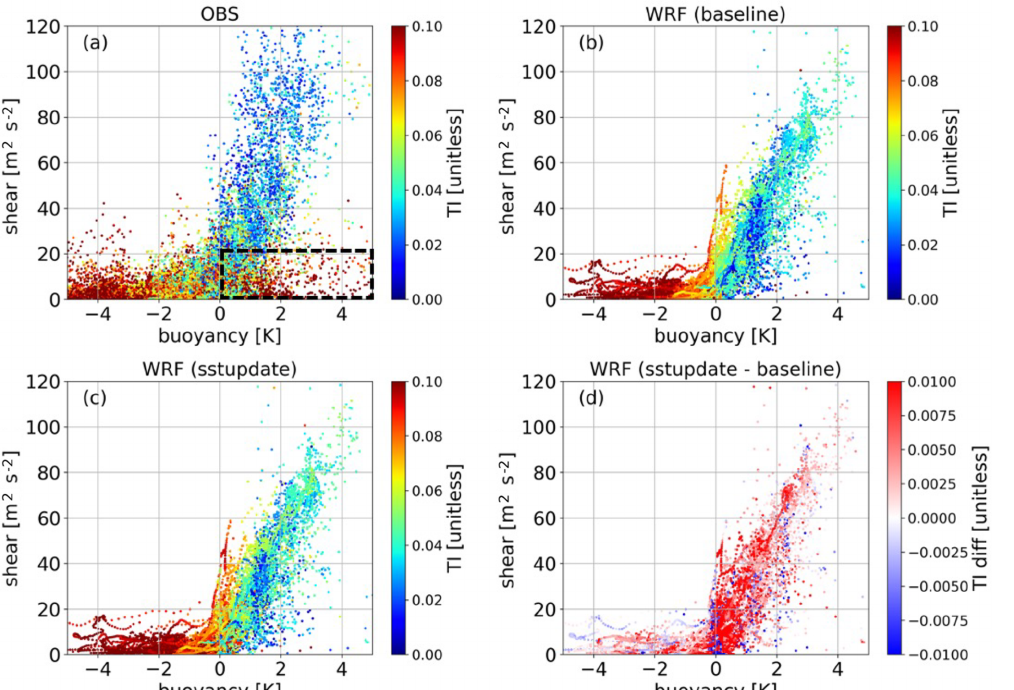
Figure 11. Scatterplots mapping the hub-height sub-grid TI in the coordinates of buoyancy ( (cid:49)θ v ) and shear ( (cid:49)U 2 + (cid:49)V 2 ) components for the entire period of study. Results of the (a) observation (OBS), (b) baseline simulation, (c) sstupdate simulation, and (d) percentage of fractional difference (%) between sstupdate and baseline simulations are displayed. The box marked with a dashed black line in (a) indicates the regime that is used to extract the data points as shown in Fig. 10e.